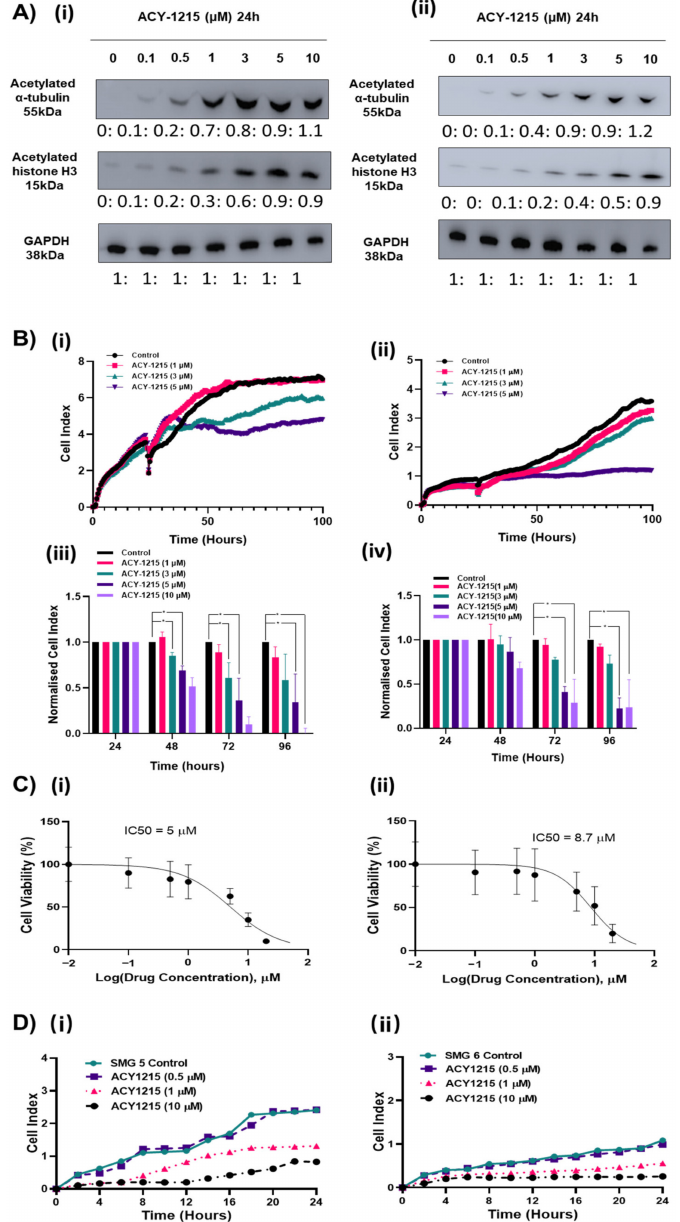
Figure 4. Low concentrations of the HDAC6 inhibitor ACY-1215 increased acetylated α -tubulin without a ff ecting cell proliferation and viability. ( A ) SMG5 ( i ) and SMG6 ( ii ) cells treated with 1–10 µ M of ACY-1215 for 24 h and α -tubulin and H3 levels were measured by western blot analysis. GAPDH was used as a loading control ( n = 3). Uncropped Western Blots are available in Figures S8 and S9. ( B ) ( i) ,( ii ) Representative graphs from the real time xCELLigence proliferation system comparing growth profiles of SMG cells after treated with 1–10 µ M ACY-1215. ( iii ),( iv ) Cell index values were normalized to both 24 h and control, observing the rate of proliferation (24–96 h). Wells were analyzed in duplicate, and three biological replicates were performed to validate results. Experiments were analyzed by a two-way ANOVA. * p < 0.05. Error bars represent SEM. ( i) ,( iii ) SMG5, ( ii) ,( iv ) SMG6. ( C ) SMG5 ( C ): ( i ) and SMG6 ( ii ) cells treated with 0–50 µ M ACY-1215 and cell